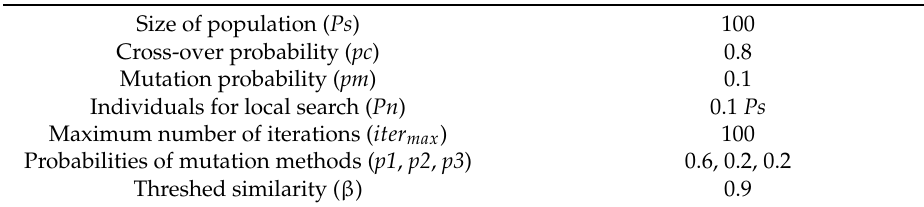
Table 9. The parameters used in our algorithm.